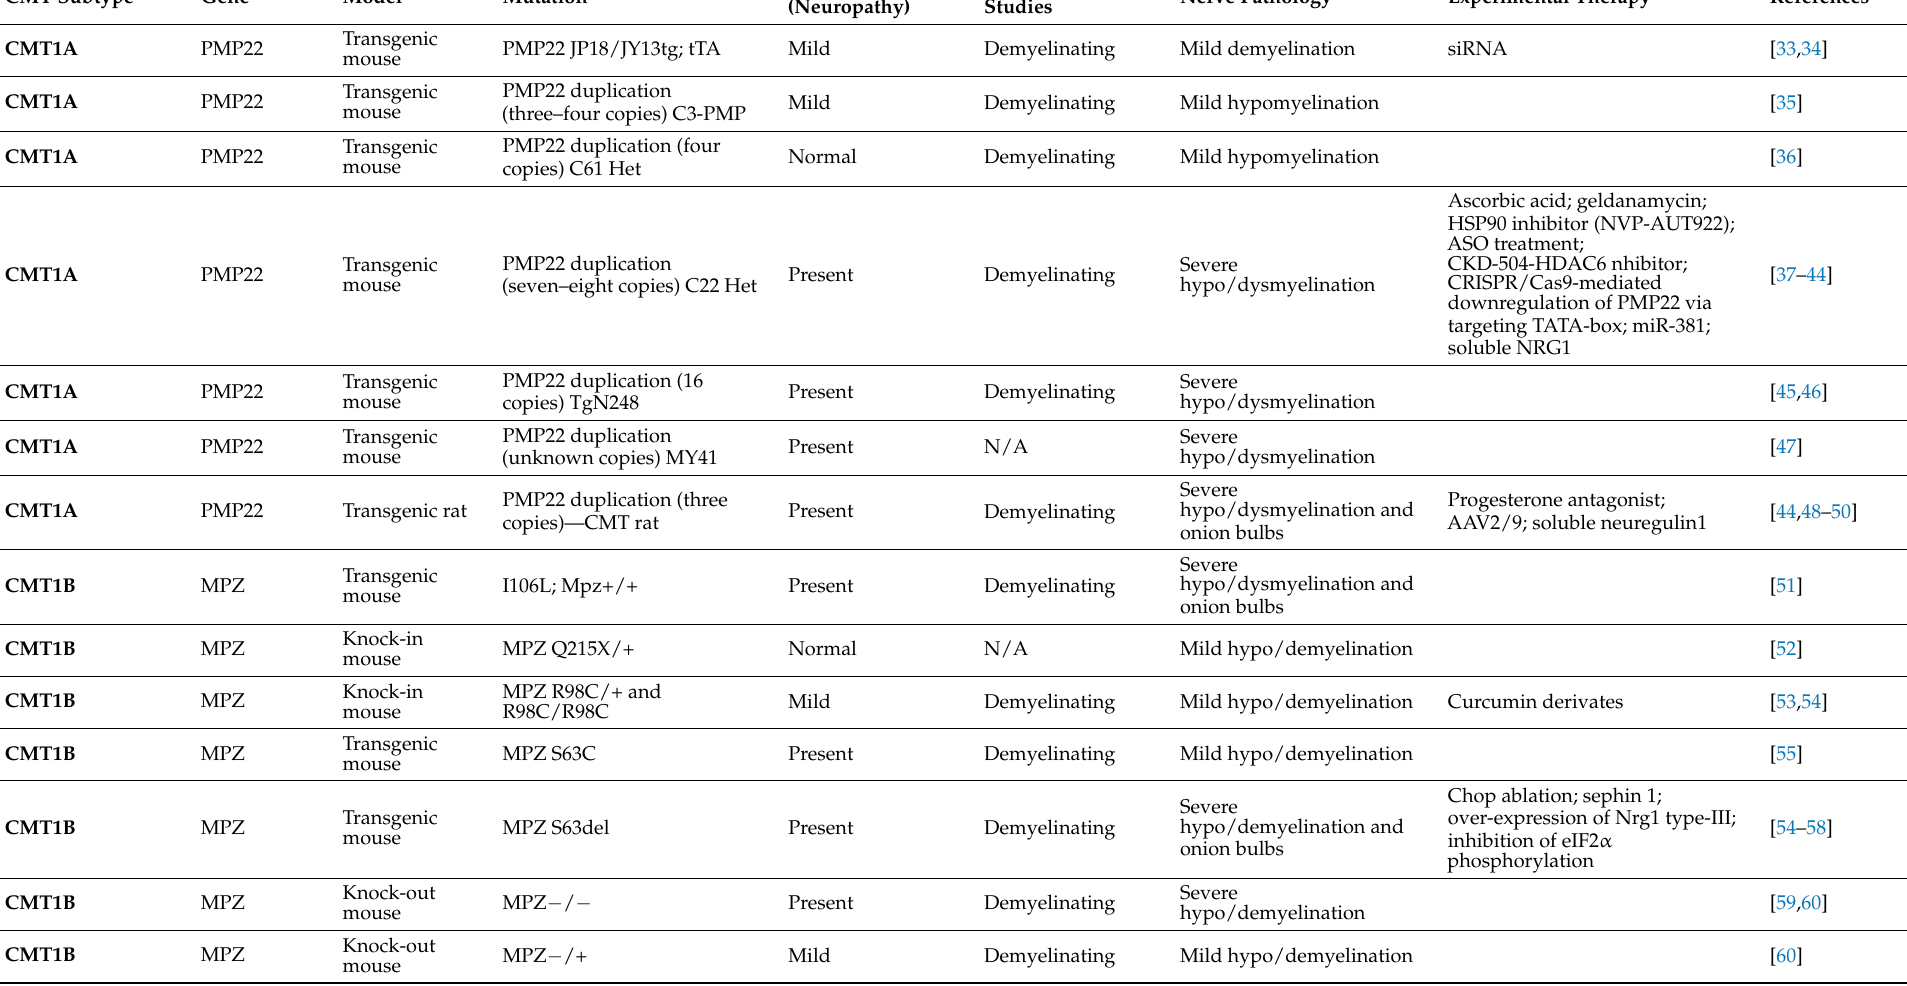
Table 1. Overview of rodent models for